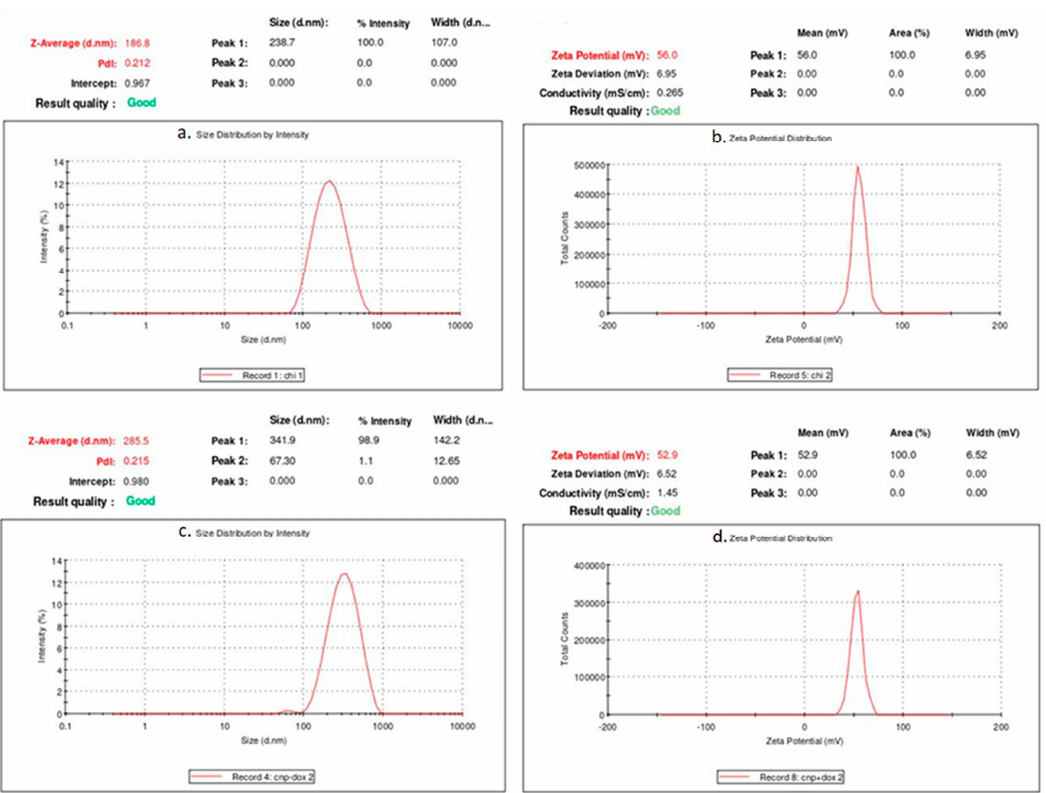
Figure 2. Dynamic Light Scattering and Zeta Potential Analysis; ( a ). Size Distribution of CNPs by Intensity, ( b ). Zeta Potential Distribution of CNPs, ( c ). Size Distribution of DCNPs by Intensity and ( d ). Zeta Potential Distribution of DCNPs.